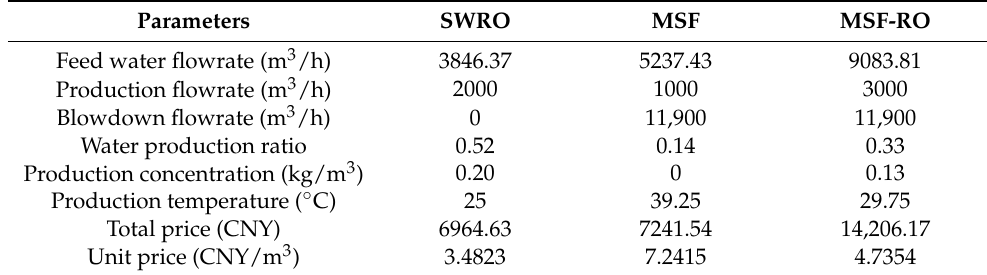
Table 24. Overall water production in option 4.